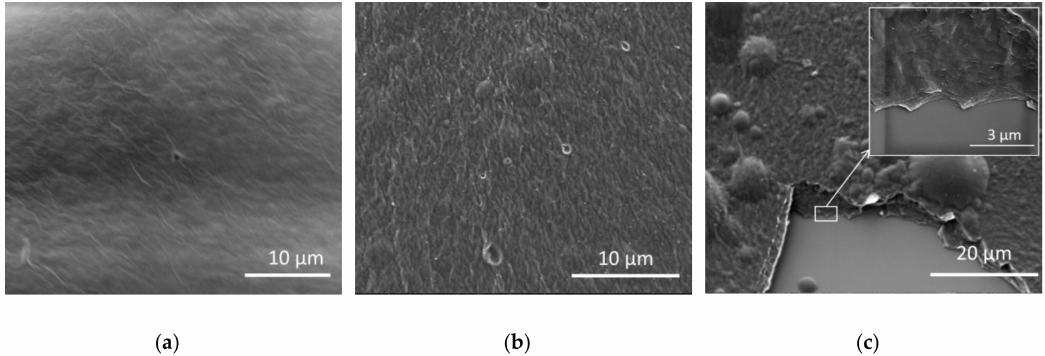
Figure 7. Scanning electron microscopy (SEM) images of GO / PVA at di ff erent mixing ratios: ( a ) 25%, ( b ) 50% and ( c ) 75%. The inset in ( c ) shows a cross-section, where stacked layer of GO are